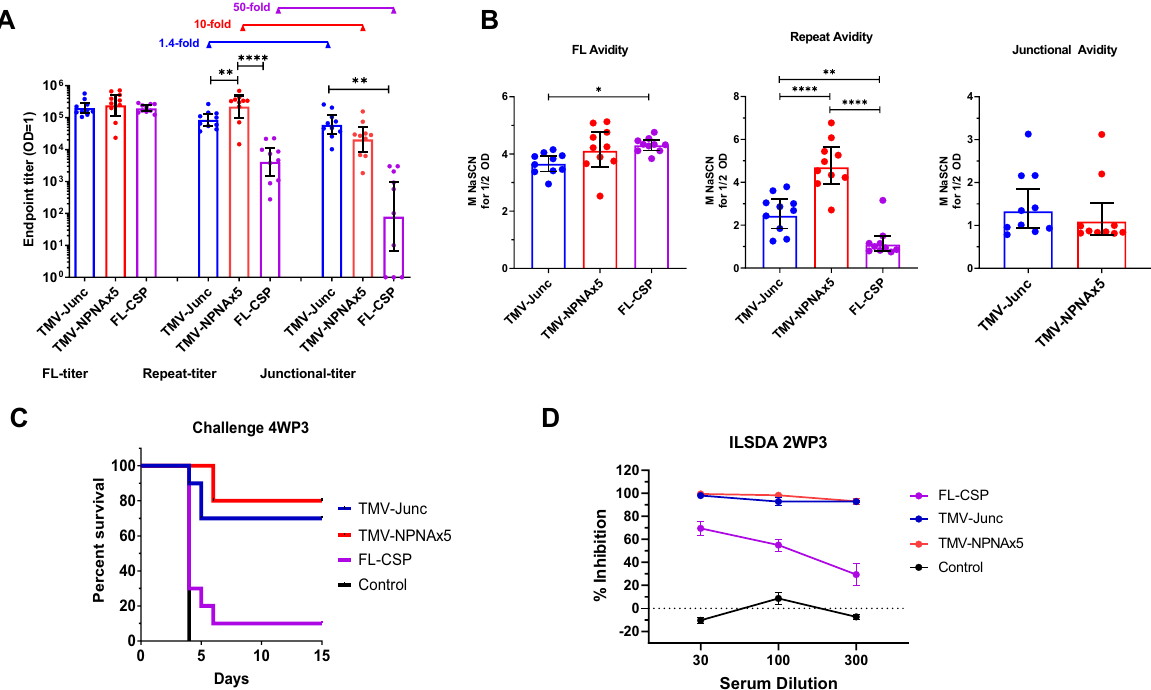
Fig. 3 Study 1 immunogenicity and functional assessment of TMV-Junc, TMV-NPNAx5, FL-CSP in mice challenged at 4WP3. A Geometric mean ± 95% CI at 2WP3 against FL-CSP (FL), repeat peptide or junctional peptide and B Avidity at 2WP3 (de fi ned as the molarity of NaSCN required to reduce OD to half maximal compared to PBS wash) against FL, NANPx6, and junctional peptide coat. Bars are geometric mean ± 95% CI. C Survival curves for mice challenged at 4WP3. D Mean ILSDA ± SEM from four experiments at 1:30, 1:100, and 1:300 using pooled serum dilutions from 2WP3. Inhibition was described as % reduction in 18s parasite RNA relative to the control wells. For ELISAs, statistical signi fi cance between groups was determined by one-way ANOVA followed by Tukey ’ s correction; **** ( p < 0.0001), ** ( p < 0.01), or * ( p < An avidity ELISA conducted using a chaotropic agent sodium thiocyanate (NaSCN), was used to show the relative strength of antibody binding (Fig. 3B). FL-CSP elicited antibody avidity for the FL-CSP plate antigen (FL-avidity) was not signi fi cantly different from that of TMV-NPNAx5 antibodies, but was higher than the avidity of TMV-Junc antibodies ( p < 0.05). Repeat-avidity of the TMV-NPNAx5 group was higher than the other two groups ( p values ≤ 0.0001), and TMV-Junc repeat-avidity was higher than FL- CSP group ( p ≤ 0.01). Strikingly, junctional peptide avidity was low for the TMV-Junc and TMV-NPNAx5 induced antibodies (<1.5 M) and it was not detectable for the FL-CSP induced antibodies, suggesting that in general antibodies bound weakly to the junctional peptide in an ELISA, as compared to binding to the major repeat peptide.